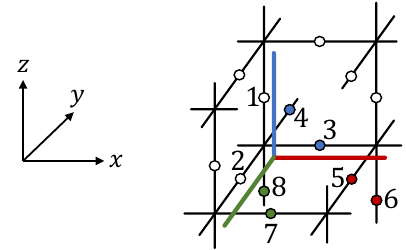
Figure 37: For edges in the cubic lattice, the “framing” is defined by green, red, and blue edges, which is a small shift of the edges [ 91 ] . Given an edge e , the hopping operator U when projected to the plane (i.e. U